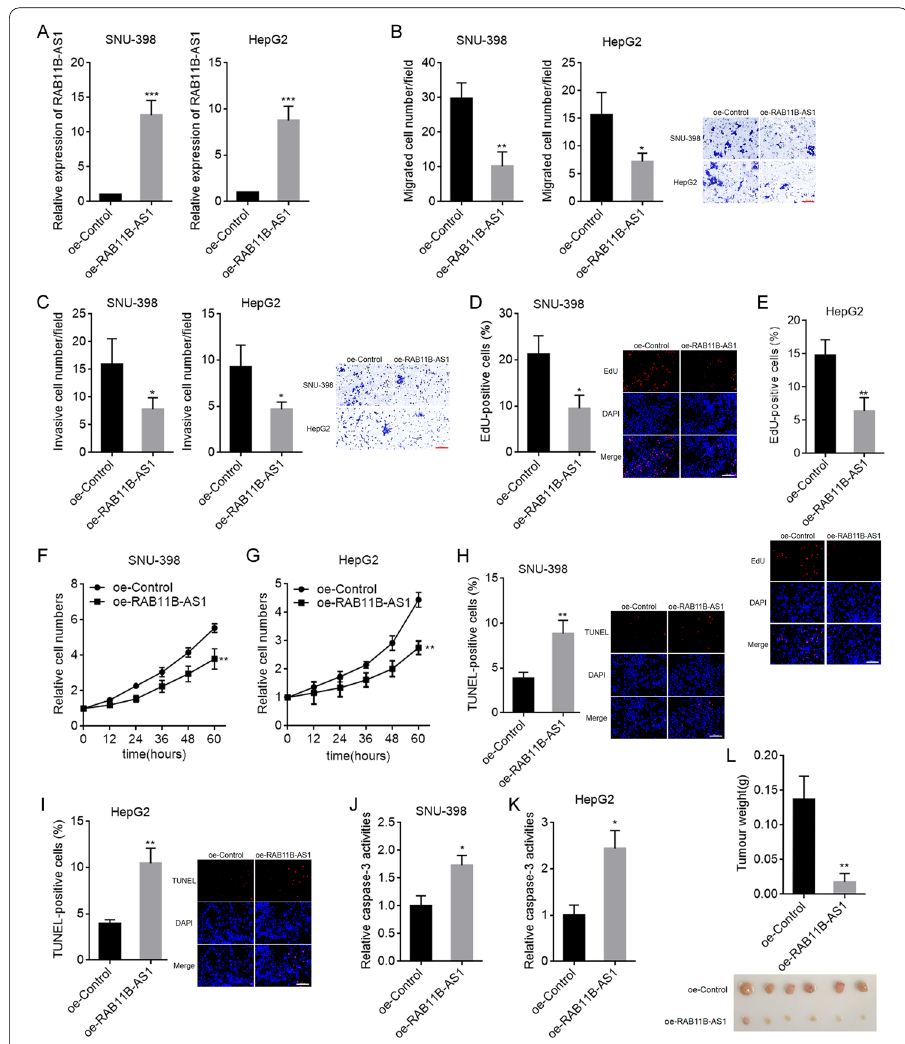
Fig. 6 The roles of RAB11B‑AS1 overexpression in HCC. A RAB11B‑AS1 expression in SNU‑398 and HepG2 cells with RAB11B‑AS1 overexpression or control was detected by RT‑qPCR. B Migration ability of SNU‑398 and HepG2 cells with RAB11B‑AS1 overexpression or control was detected by transwell migration assay. Scale bars, 100 µm. C Invasion ability of SNU‑398 and HepG2 cells with RAB11B‑AS1 overexpression or control was detected by transwell invasion assay. Scale bars, 100 µm. D Cellular proliferation of SNU‑398 cells with RAB11B‑AS1 overexpression or control was detected by EdU assay. Scale bars, 100 µm. E Cellular proliferation of HepG2 cells with RAB11B‑AS1 overexpression or control was detected by EdU assay. Scale bars, 100 µm. F Cellular proliferation of SNU‑398 cells with RAB11B‑AS1 overexpression or control was detected by CCK‑8 assay. G Cellular proliferation of HepG2 cells with RAB11B‑AS1 overexpression or control was detected by CCK‑8 assay. H Cellular apoptosis of SNU‑398 cells with RAB11B‑AS1 overexpression or control was detected by TUNEL assay. Scale bars, 100 µm. I Cellular apoptosis of HepG2 cells with RAB11B‑AS1 overexpression or control was detected by TUNEL assay. Scale bars, 100 µm. J Cellular apoptosis of SNU‑398 cells with RAB11B‑AS1 overexpression or control was detected by caspase‑3 activity assay. K Cellular apoptosis of HepG2 cells with RAB11B‑AS1 overexpression or control was detected by caspase‑3 activity assay. L Weight and photograph of subcutaneous tumors formed by SNU‑398 cell with RAB11B‑AS1 overexpression or control. Results are shown as mean SD of n 3 independent experiments ( B – K ) or n 6 mice in each ± = = group ( L ). * P < 0.05, ** P < 0.01, *** P < 0.001 by Student’s t ‑test ( A – K ) or Mann–Whitney test ( L